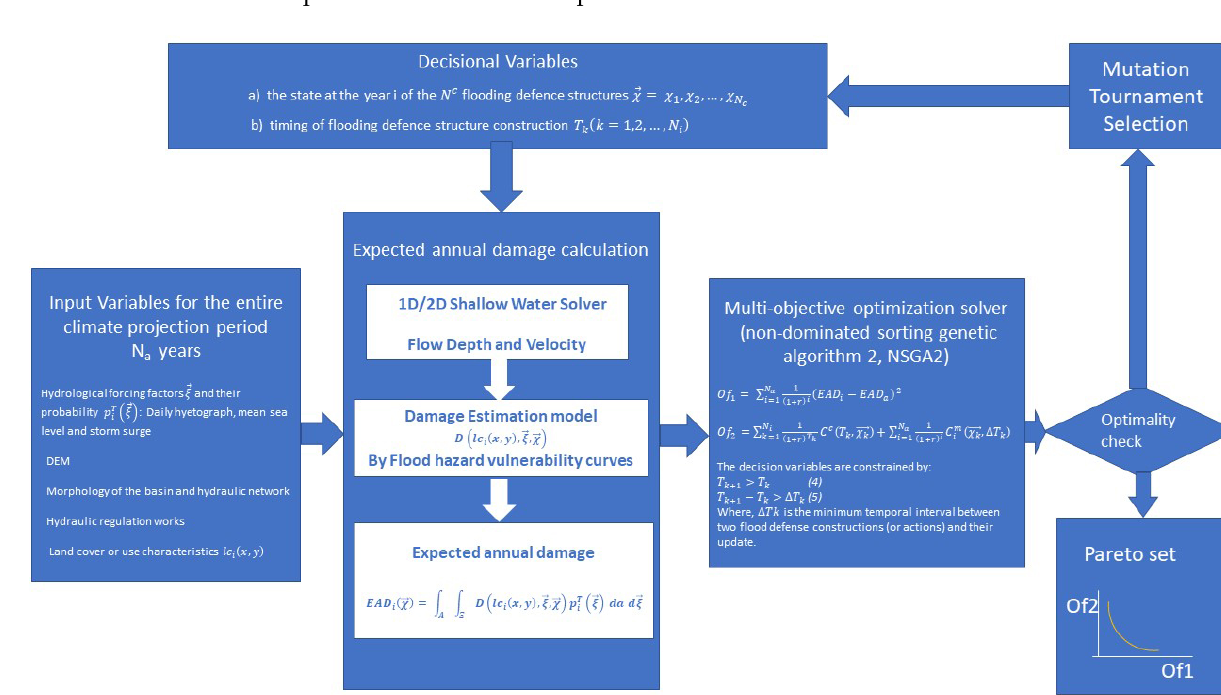
Figure 2. Sketch of model